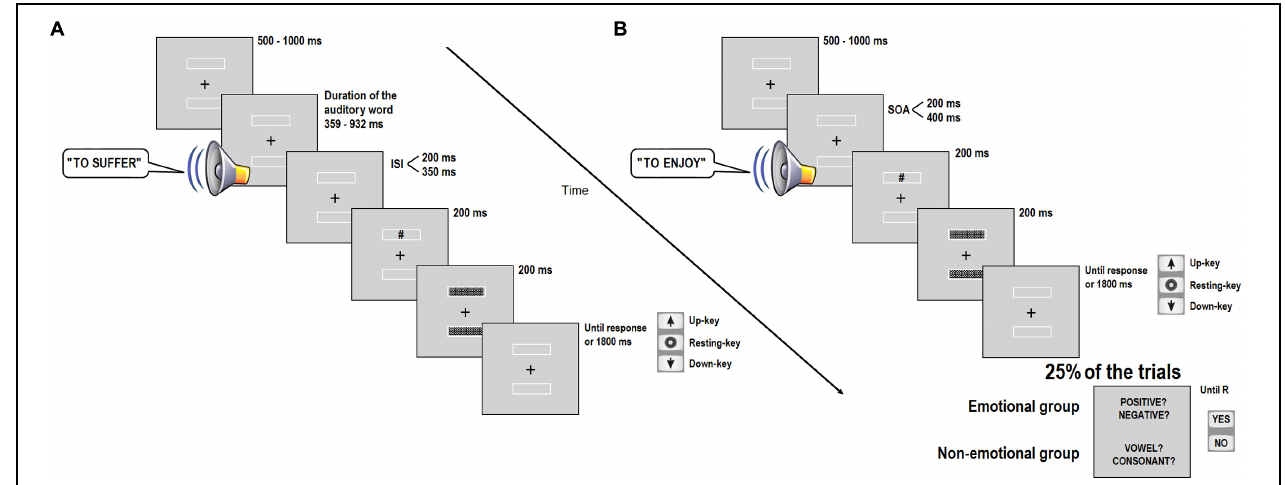
FIGURE 1 | Illustration of the sequence of events in Experiments 1 (A) and 2